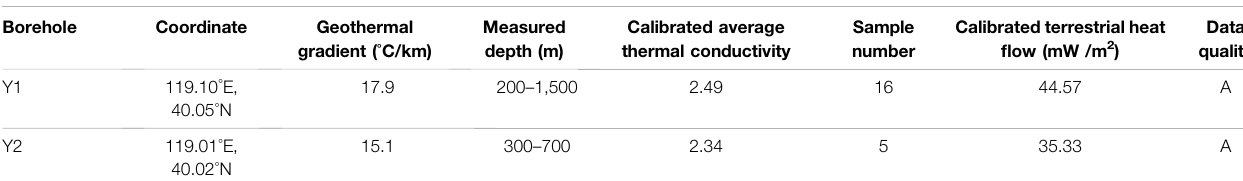
TABLE 1 | Calculated result of terrestrial heat fl ow in the Yanheying Basin. Borehole Coordinate